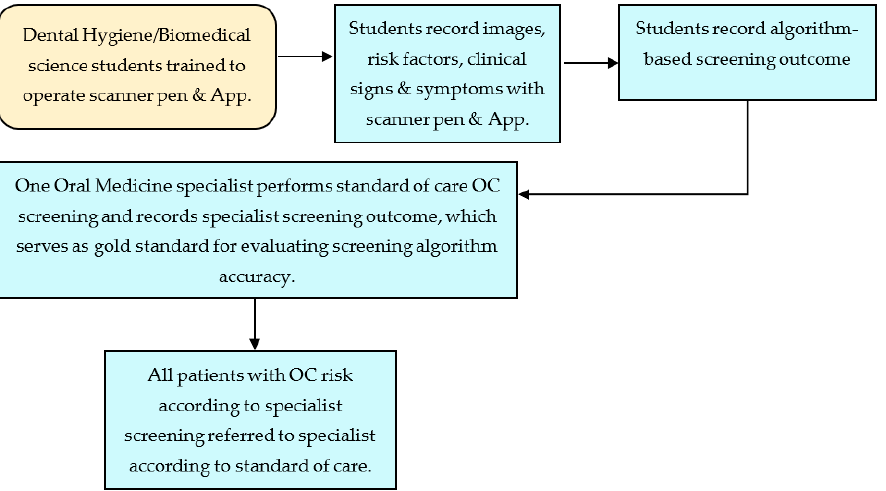
Figure 1. Flow diagram of the protocol.